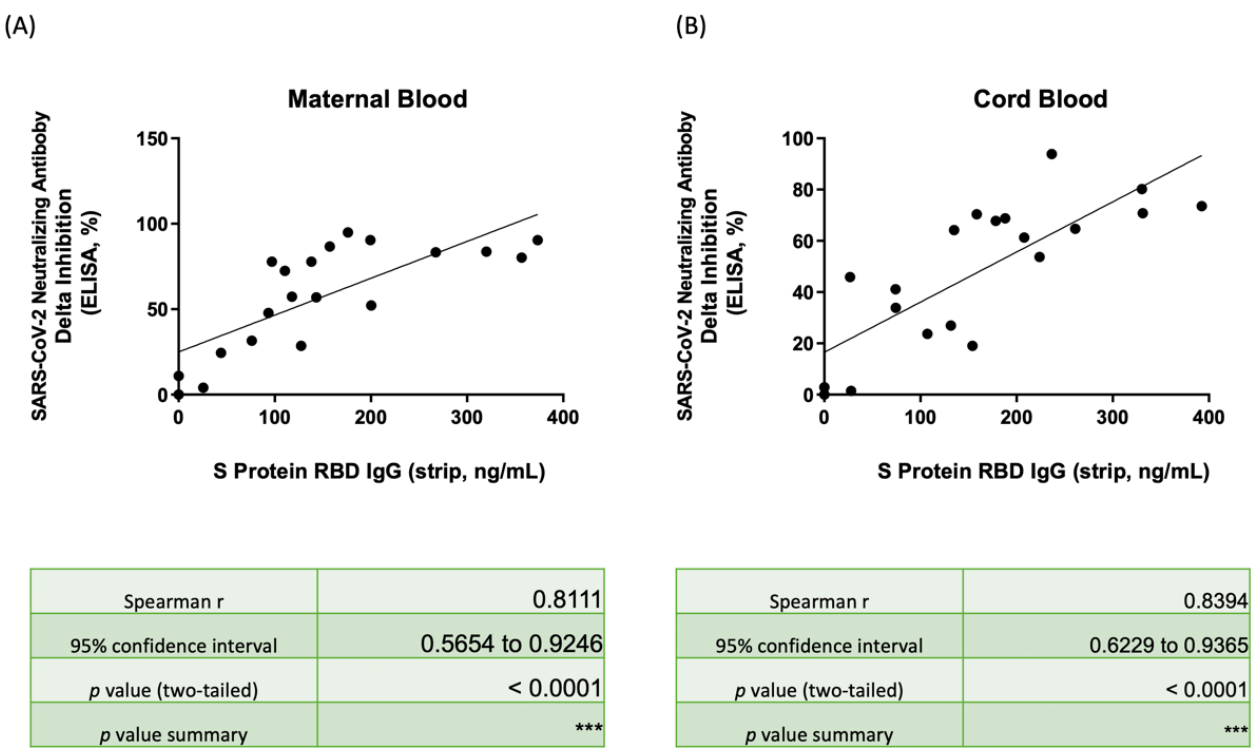
Figure 4. ( A ) Scatter plot showing the correlation between SRBD IgG by the lateral flow immunoas- say/spectrum analyzer and the neutralizing antibody inhibition rates against Delta-type SARS-CoV-2 by ELISA in maternal serum. ( B ) Scatter plot showing the correlation between SRBD IgG by the lateral flow immunoassay/spectrum analyzer and the neutralizing antibody inhibition rates against Delta-type SARS-CoV-2 by ELISA in neonatal cord blood. SRBD, spike protein receptor binding domain; ELISA, enzyme-linked immunosorbent assay. *** p < 0.001.